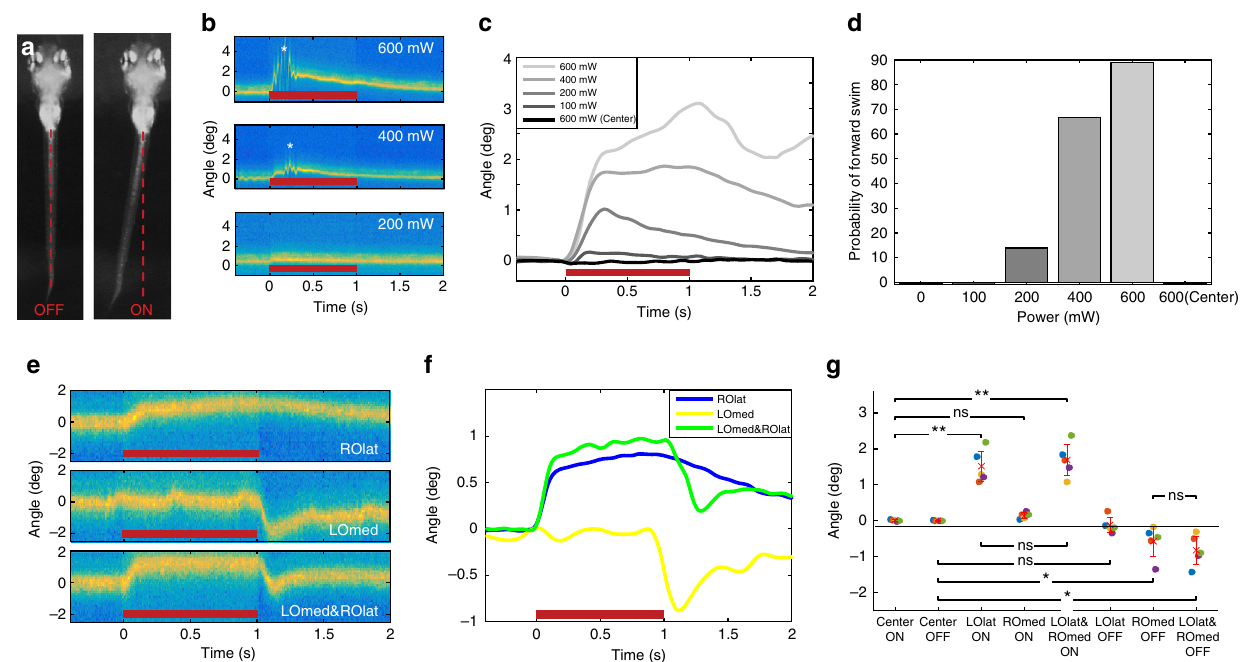
Fig. 3 Otolith trapping results in coordinated compensatory movements in the tail. a Tail position of a larva before ( left ) and during ( right ) a 600 mW optical trap to the outside of the right otolith. b Tail positions during trap ( red bar ) with different laser powers. Forward swimming ( asterisks ) is evident during the 400 and 600 mW trials. c Tail de fl ection increases with laser power, and a 600 mW trap to the centre of the otolith has no effect (average of trials from one larva). Responses for all larvae are shown in Supplementary Fig. 4. d The probability of forward swimming increases with increased laser power ( n = 6 larvae, 3 trials at each power). e Tail positions for a representative trial during a trap (600 mW) to the lateral edge of the right otolith (ROlat), the interior of the left otolith (LOmed), or a double trap of both. f Average of trials from one larva. The combined tail response is roughly a linear sum of the two separate traps ’ effects. Responses for all larvae are shown in Supplementary Fig. 5. g Responses to the onsets and offsets of different trap combinations. n = 5 larvae ( different colours ), and each point represents an average of 2 – 3 trials (after the application of exclusion criteria, see ‘ Methods ’ section). Mean + / − SEM is shown, * p < 0.05, ** p < 0.01, paired t test). Larvae were tested in both left/right orientations, but for clarity,